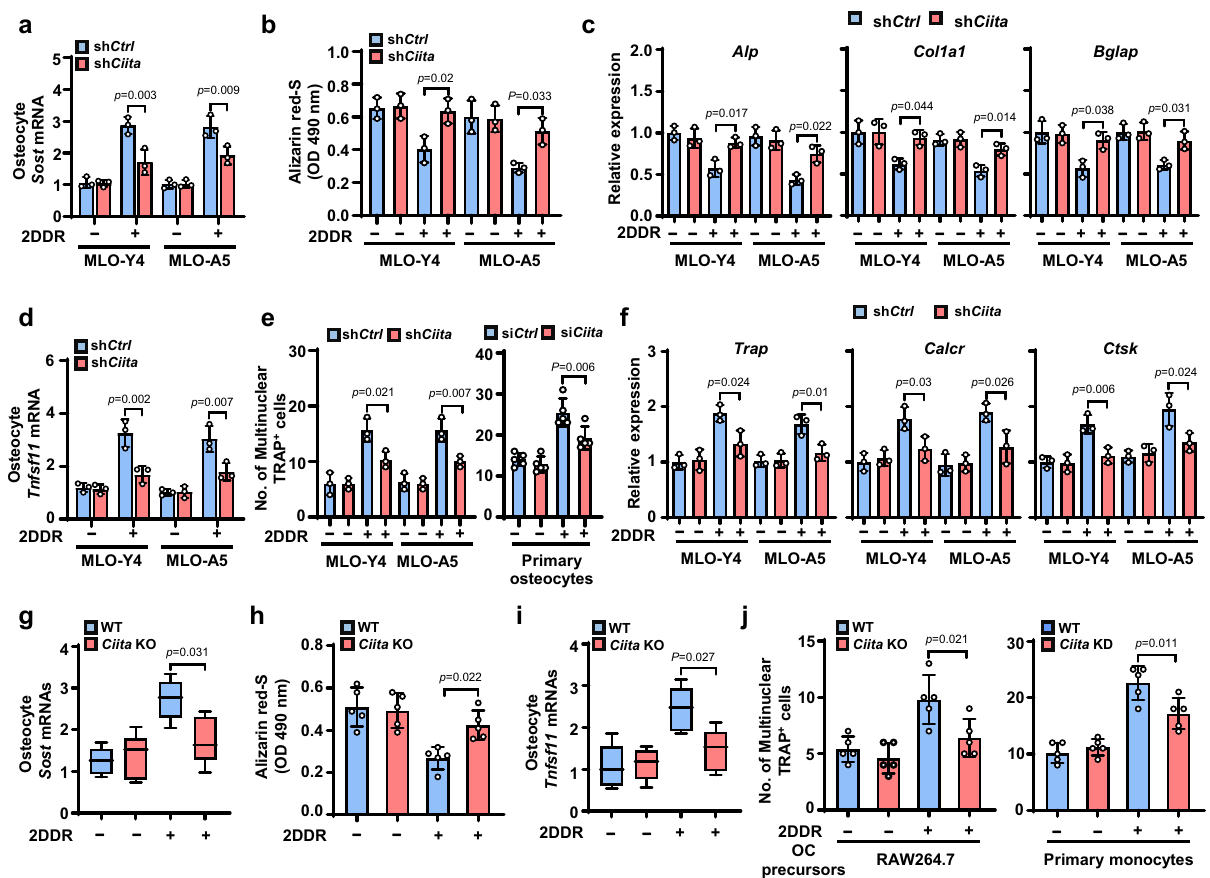
Fig. 4 Depletion of CIITA in osteocytes abrogates effects of 2DDR on cytokine secretion, osteoclastogenesis, and suppressed osteoblastogenesis. MLO-Y4 and MLO-A5 osteocytes carried with non-targeted control shRNAs (sh Ctrl ) or Ciita shRNAs (sh Ciita ) were cultured with or without 2DDR for 2 days, given fresh medium, and cultured for another 2 days, and then the cells and the CM were collected. The osteoblast precursor MC3T3-E1 and the osteoclast precursors Raw264.7 cells or primary monocytes were cultured with or without the osteocyte CM. After culturing, the cells were subjected to Alizarin red-S staining to assess osteoblast differentiation, to TRAP staining to assess osteoclast differentiation, or to real-time PCR to assess the differentiation-associated gene expression. a – f Shown are summarized data for Sost mRNAs ( a ), Alizarin red-S staining ( b ), the relative expression of osteoblast differentiation – associated genes Alp , Col1a1 , and Bglap ( c ), Tnfsf11 mRNA ( d ), the numbers of multinuclear ( ≥ 3) TRAP + cells ( e ), and the relative expression of osteoclast differentiation – associated genes Trap , Calcr , and Ctsk ( f ). Data are mean ± SD (n = 3 biological replicates). g – j Osteocytes isolated from WT or osteocyte-speci fi c Ciita -KO mice ( n = 5 mice/group) were cultured with or without 1 mM 2DDR for 2 days for collecting the cells and the osteocyte CM. MC3T3-E1 or Raw264.7 cells cultured with osteocyte CM were subjected to Alizarin red-S staining, TRAP staining, or real-time PCR. Shown are summarized data for Sost mRNA levels in osteocytes ( g ), Alizarin red-S staining ( h ), Tnfsf11 mRNA levels in osteocytes ( i ), and numbers of multinuclear ( ≥ 3) TRAP + cells ( j , left). Box plots ( g , i ) indicate median, 25 th and 75 th percentiles, and minima and maxima of the distribution. Data are presented as mean ± SD. ( j , right) Primary osteocytes wild-type or carried with Ciita siRNAs (si Ciita ) were cultured in the same fashion as in ( a ) to collect the CM. The numbers of multinuclear ( ≥ 3) TRAP + cells were counted in the cultures of primary monocytes with or without the osteocyte CM. Data are means± SD. P values were determined using one-way ANOVA with Tukey ’ s multiple comparisons